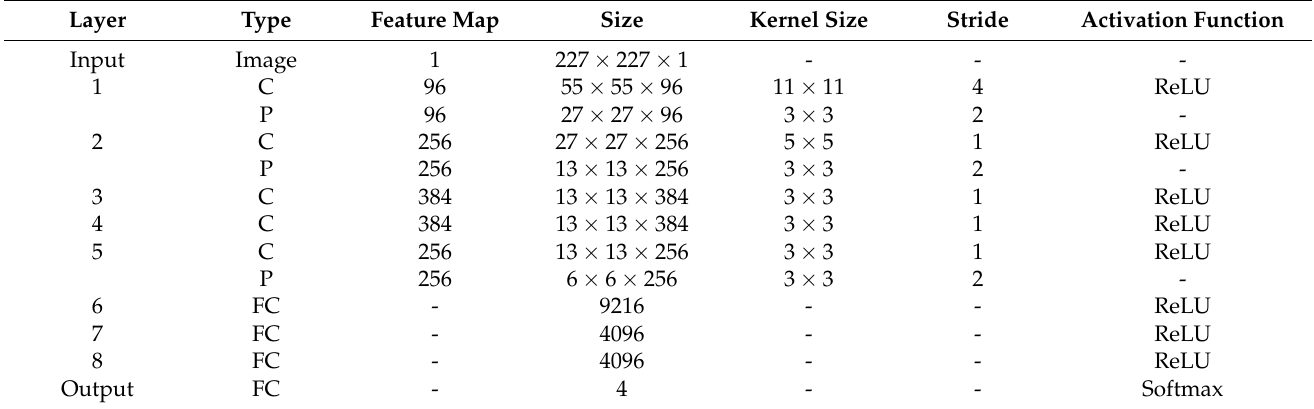
Table 1. Description of AlexNet architecture (C—convolutional layer, P—Max pooling, FC—fully connected). Layer